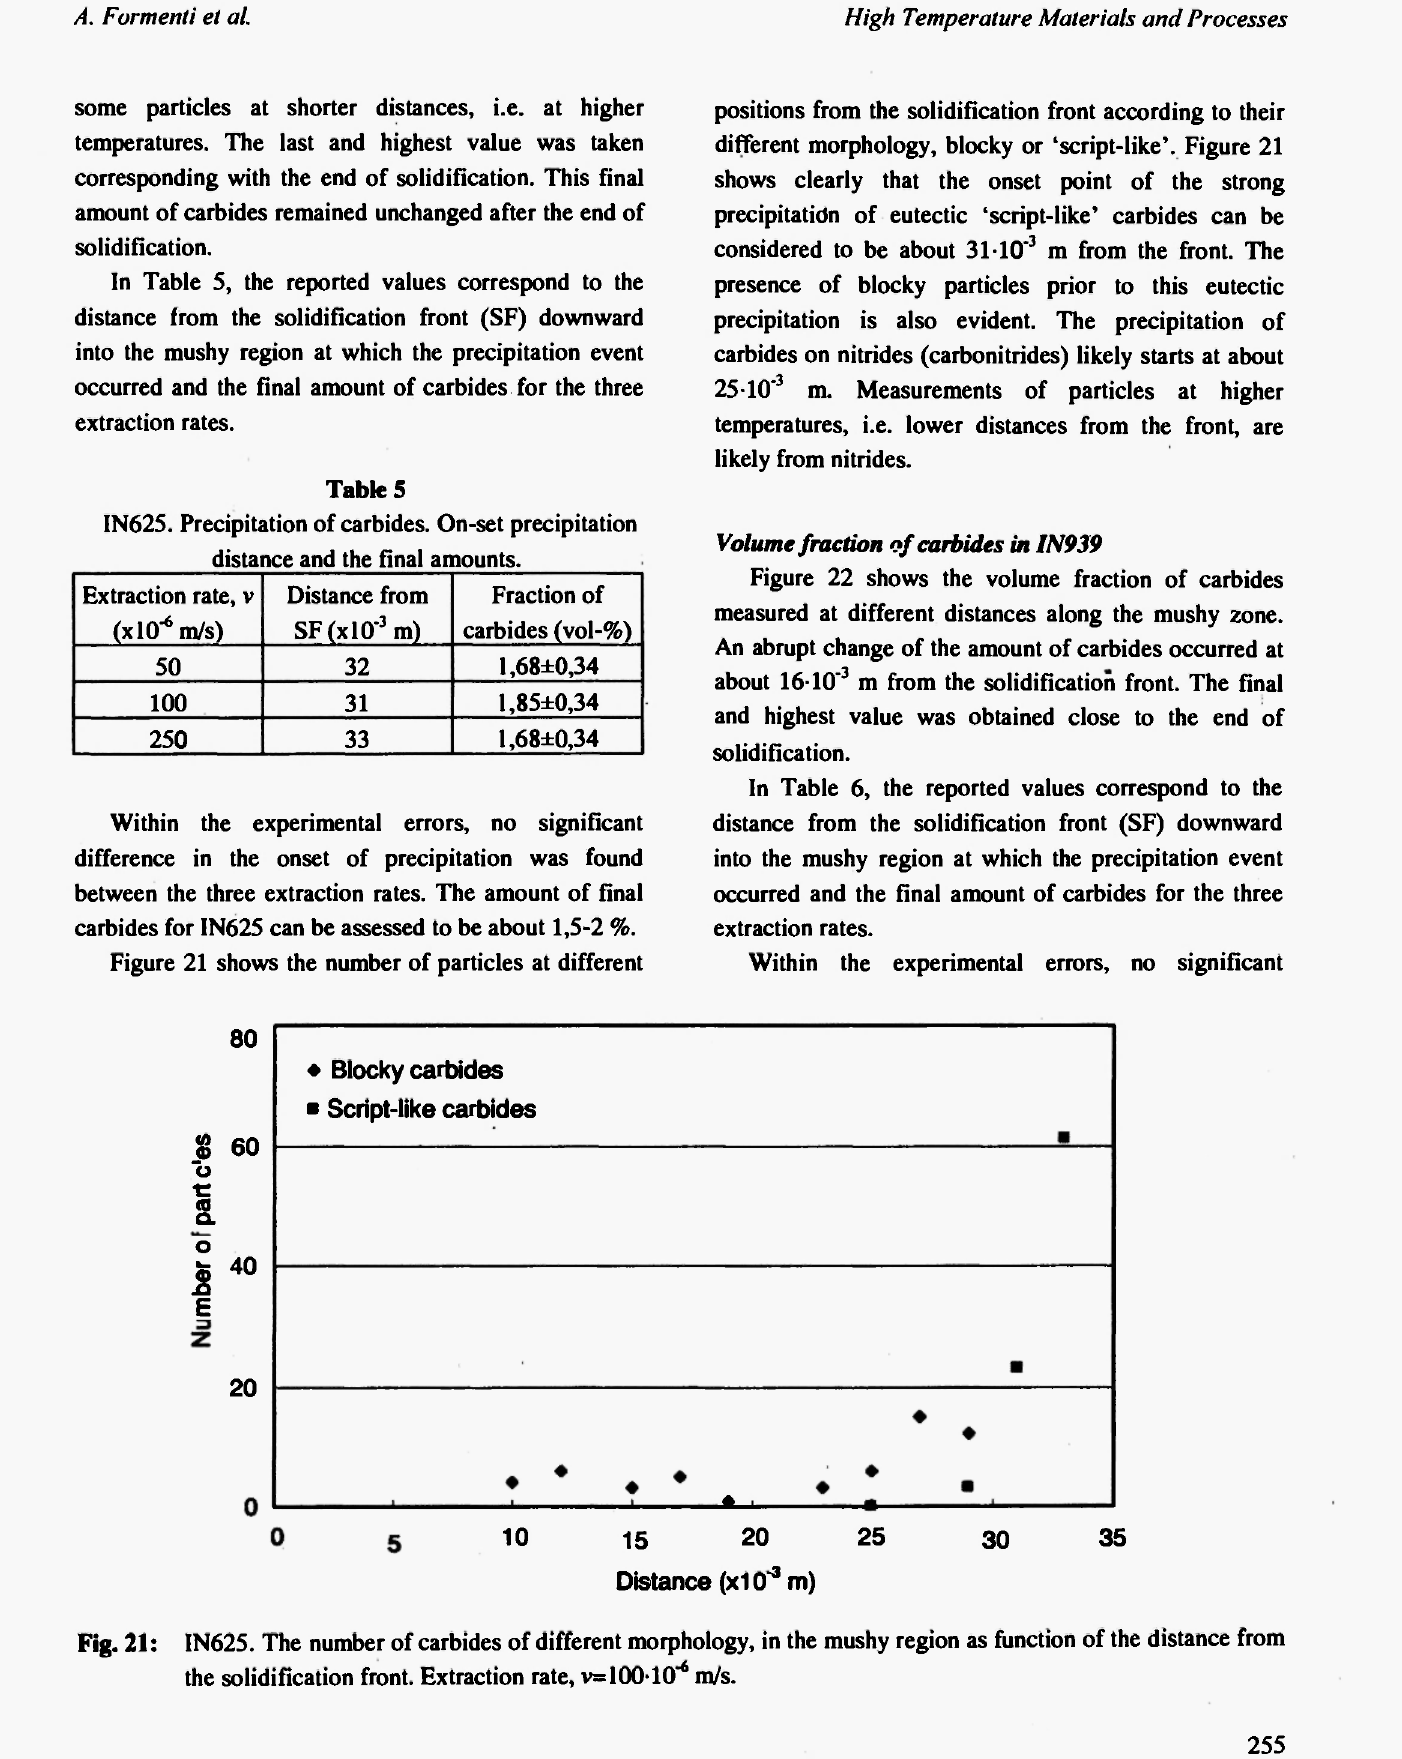
IN625. The number of carbides of different morphology, in the mushy region as function of the distance from the solidification front. Extraction rate, v^lOO-KT 6